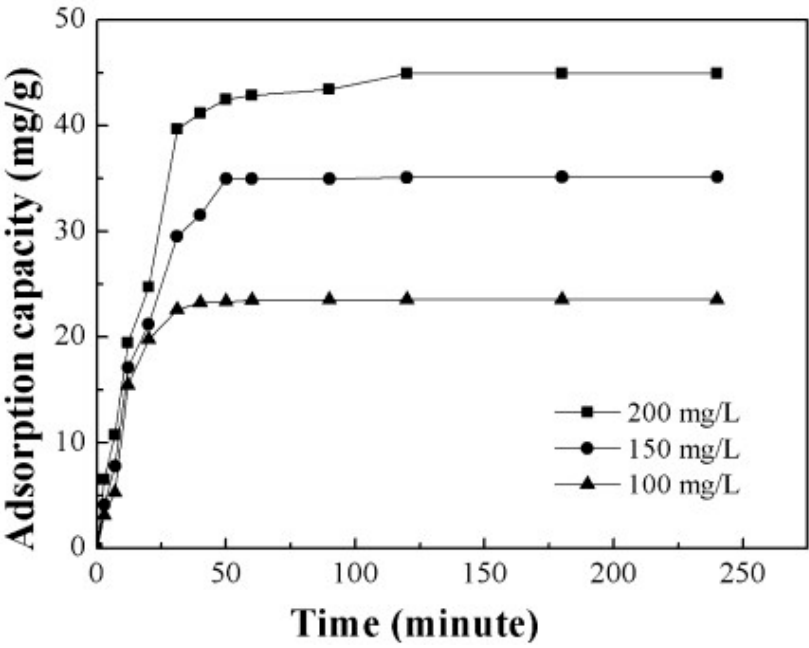
Figure 9. Effect of contact time and initial concentration on the adsorption of Cr 6+ of the PAN/PPy nanofiber mat. Temperature = 25 ◦ C, pH = 2.0. Adapted with permission from reference [77].